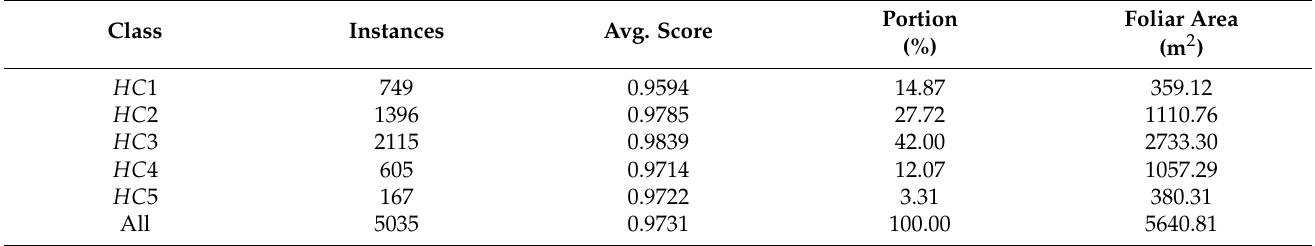
Table 5. Automated plant detection counts and per class and segmented canopy area